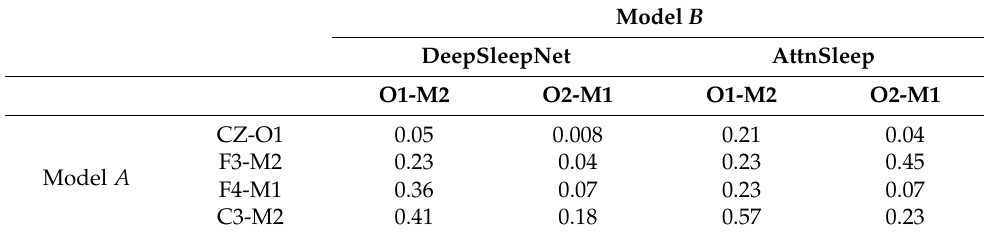
Table 2. The ASO significance score (cid:101) min of pairs of models A and B , where model A is trained on data from central and front EEG channels, and model B is trained on data from back channels. If (cid:101) min < 0.5, then A is stochastically dominant over B . The lower the value of (cid:101) min , the higher the confidence that A is better than B